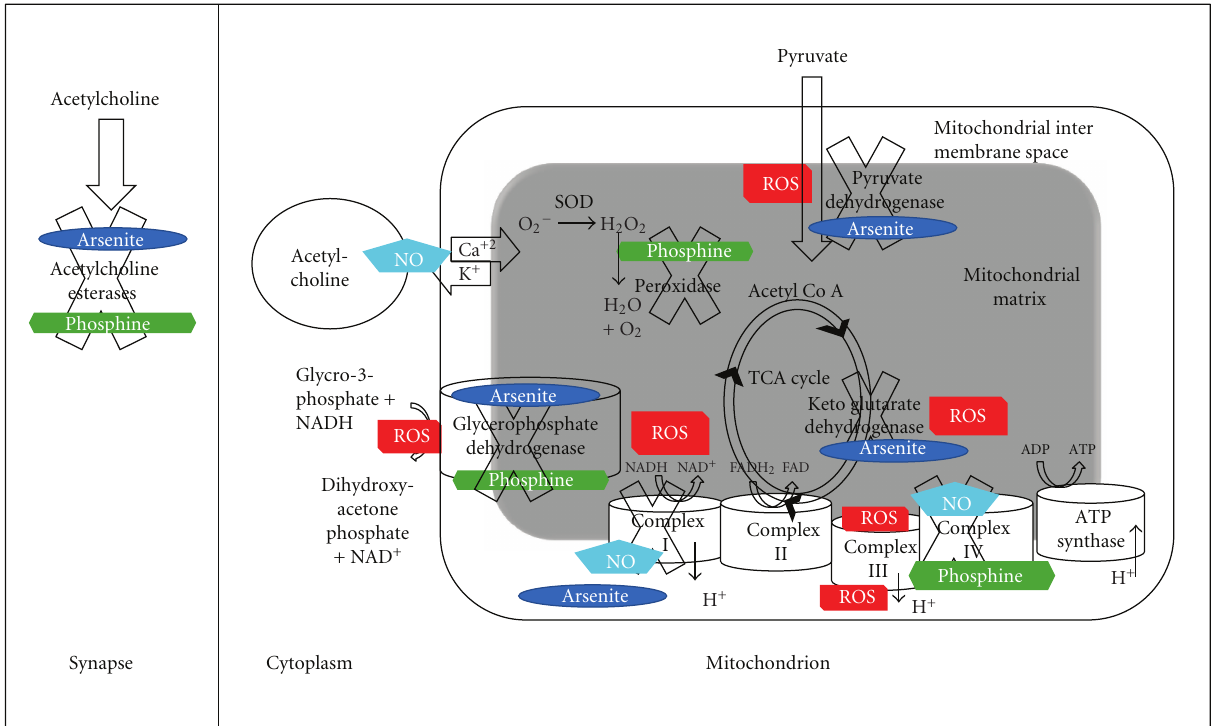
Figure 1: Interaction of phosphine with enzymes involved in metabolic processes and acetylcholine signalling. Sites of interaction with arsenite and nitric oxide (NO) are also shown: phosphine (green), arsenite (dark blue), and nitric oxide (light blue). Sites of ROS generation (red) are indicated as well. The cross behind the names of targeted enzymes indicates that they are inhibited. The potassium and calcium currents are regulated by acetylcholine via NO. Ca 2+ triggers the release of acetylcholine from vesicles in the cytoplasm into the neuronal synapse. The acetylcholinesterase degrades acetylcholine, which reduces the strength of neurotransmission. The net e ff ect is that arsenite and phosphine increase acetylcholine signalling by inhibiting the esterase. FAD/FADH2 (Flavin adenine dinucleotide oxidised/reduced), NAD + /NADH (nicotinamide adenine dinucleotide oxidised/reduced), ADP/ATP (adenosine di/tri nucleotide), NO (nitric oxide), ROS (reactive oxygen species), and TCA (tricarboxylic